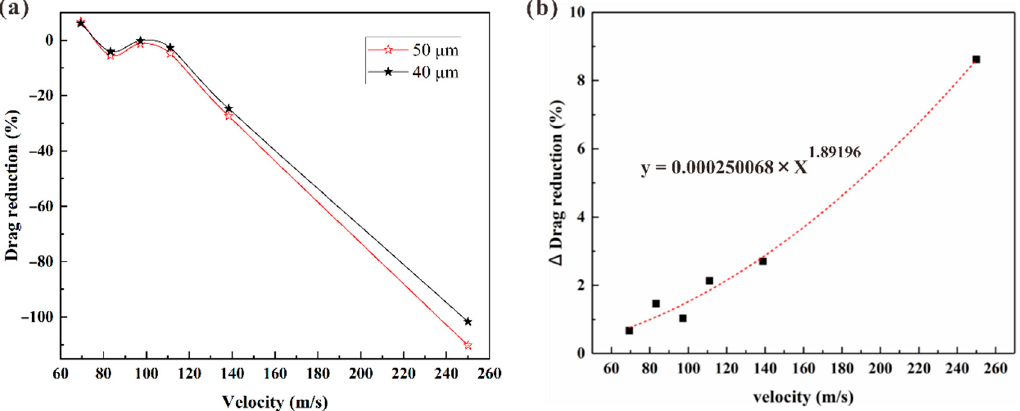
Figure 11. ( a , b ) Influence of different structure height on drag reduction ratio under variations in flow velocities.